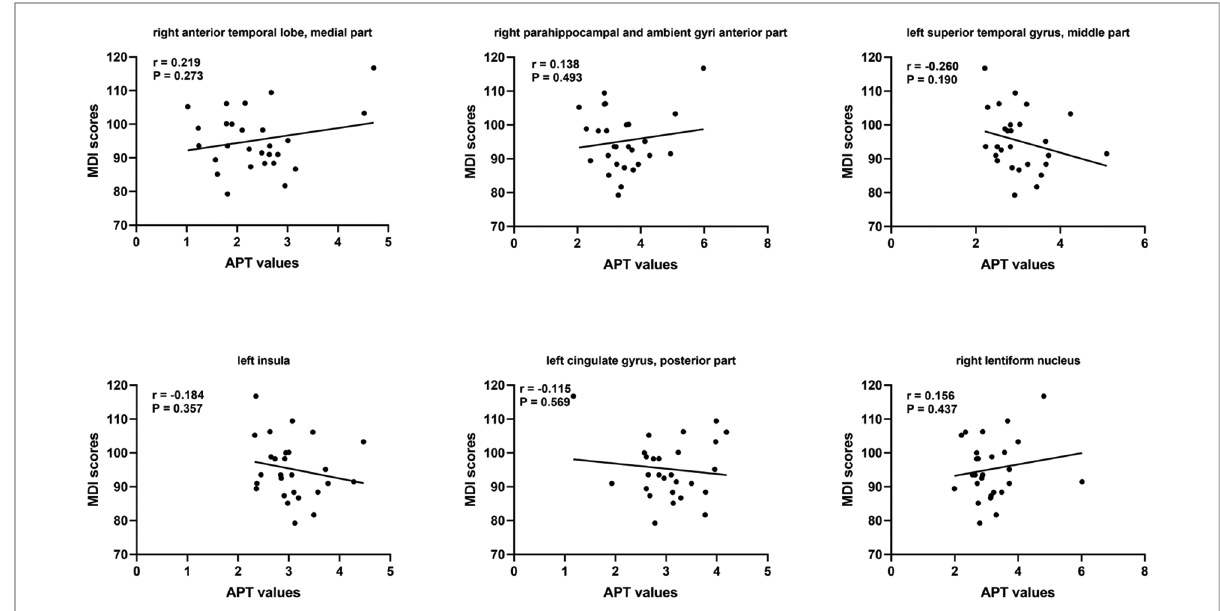
FIGURE 3 Relationship between MDI scores and region APT values in HIE/MRI+ group.